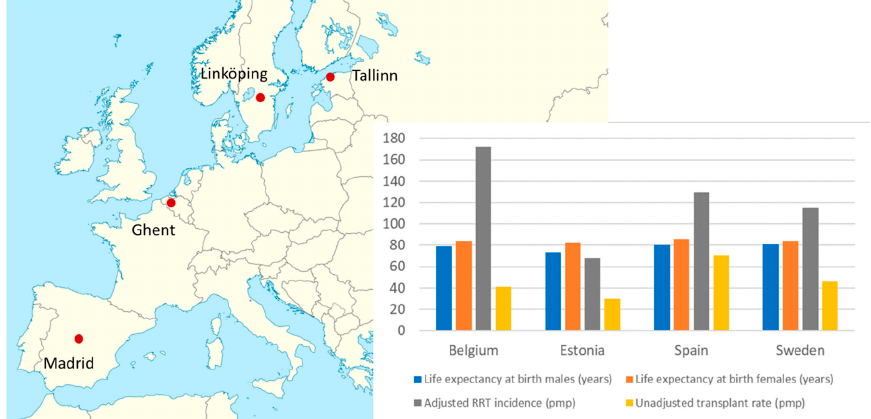
Figure 5. Location of centres and country life expectancy (GBD 2017 study) [57], renal replacement therapy (RRT) incidence and transplant rate (data from ERA-EDTA Registry, Belgium data correspond to Dutch-speaking Belgium) [58].